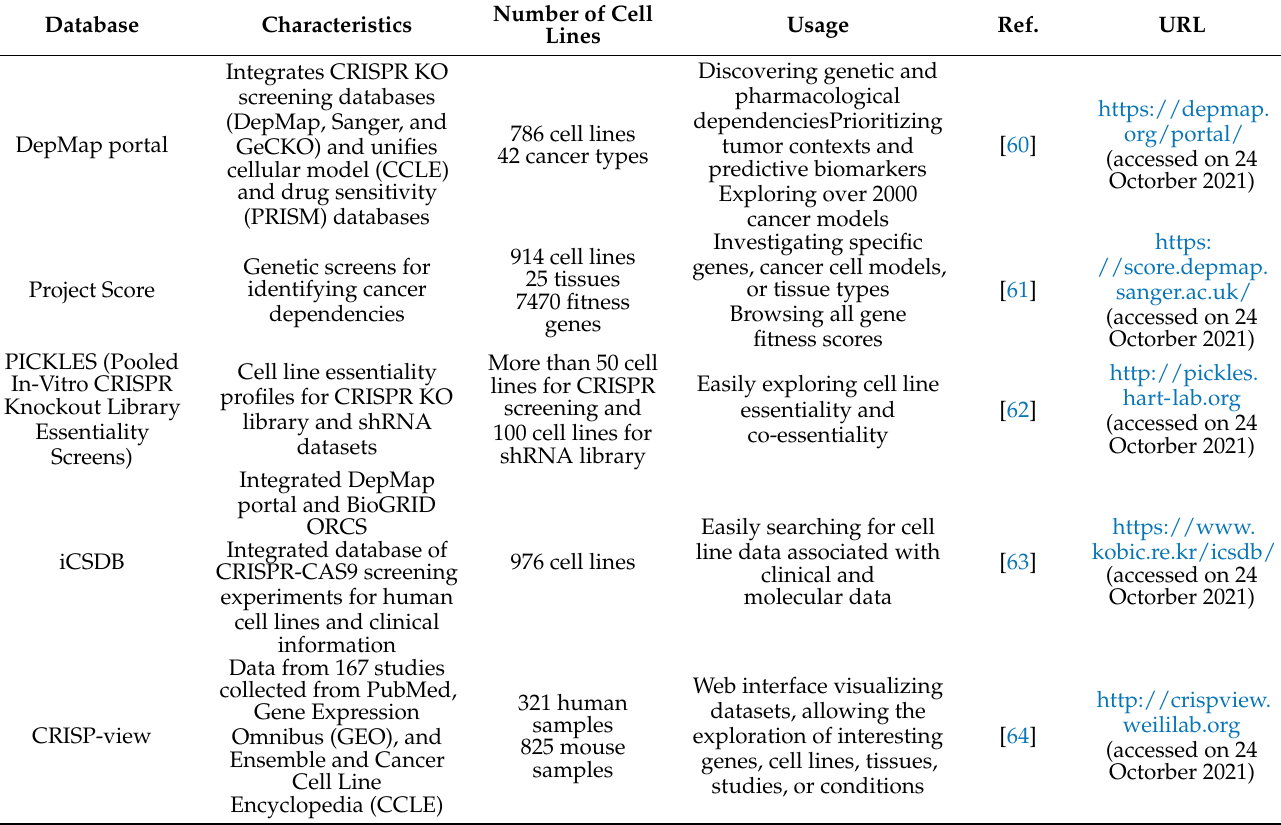
Table 4. CRISPR screening